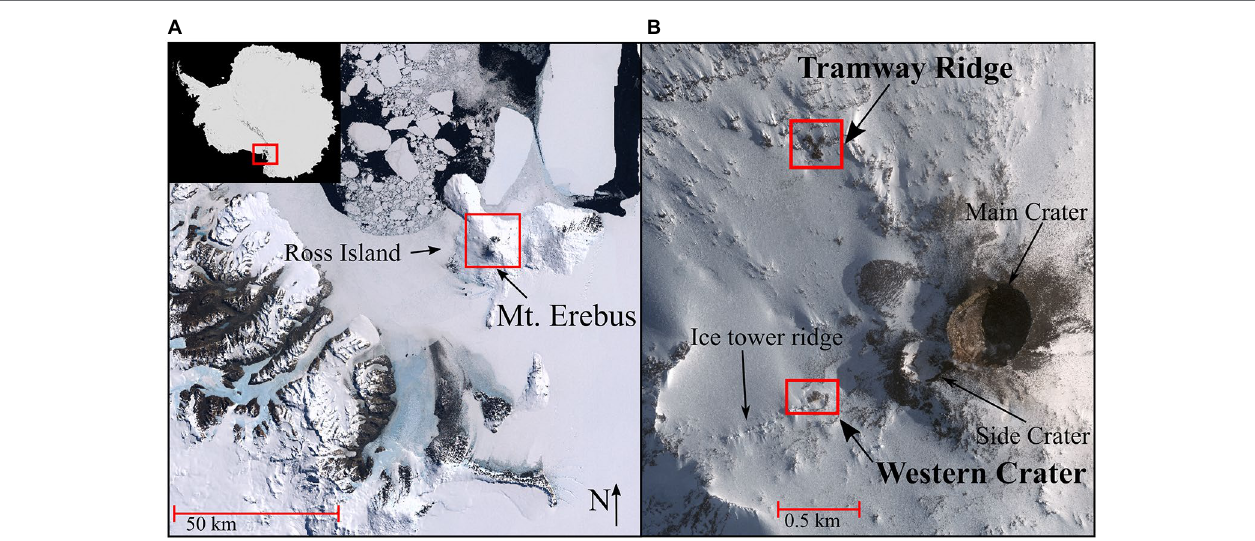
FIGURE 1 | (A) Satellite image of Antarctica (top left inset, red rectangle indicates Victoria Land); main image shows Victoria Land and Ross Island, with Mt. Erebus ( − 77.53 and 167.17 DD) identified in the red rectangle. (B) The sampling sites on Mt. Erebus (red rectangles), Tramway Ridge ( − 77.519444 and 167.116389 DD) and Western Crater ( − 77.519167 and 167.187778 DD), and other main geothermal features on the Mt. Erebus summit. Satellite image in (A) is from the Antarctic Digital Database Map Viewer https://www.add.scar.org/, Open Source. Satellite image in (B) was purchased from DigitalGlobe Incorporated, Longmont CO United States